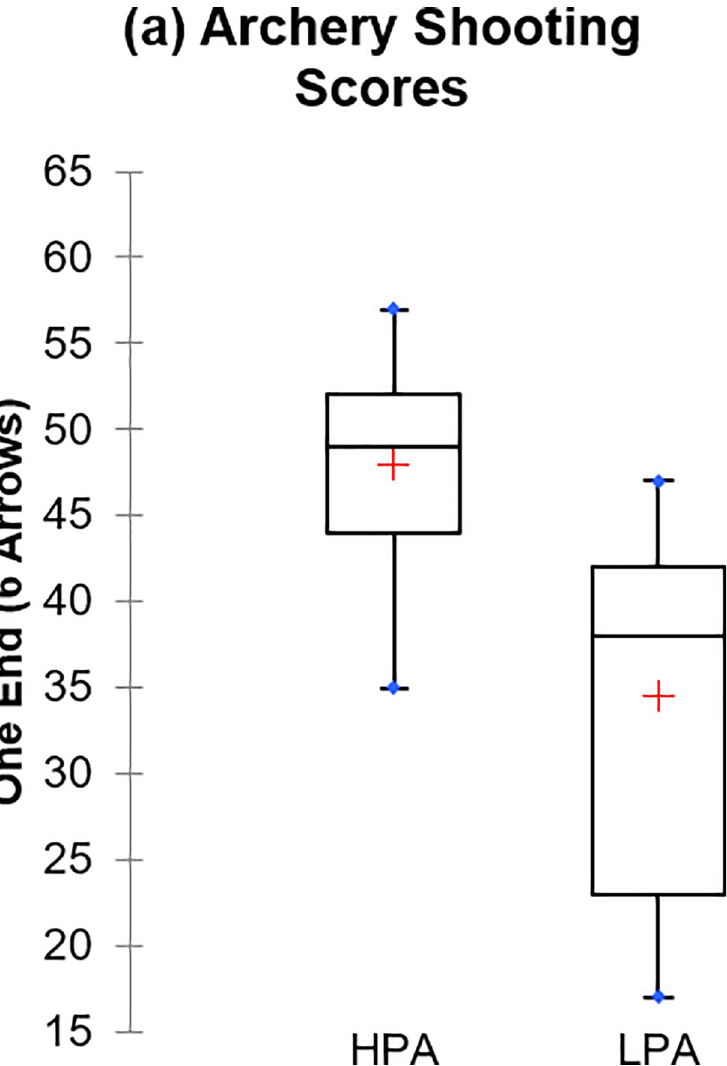
Fig 1. Box plots of the significant variables evaluated. (a) Archery shooting score.; (b) Vertical Jump; (c) Core Muscle